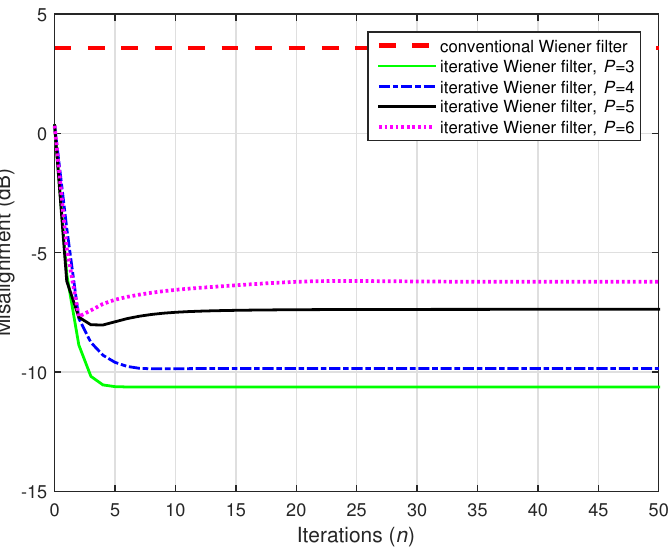
Figure 13. Performances of the conventional and iterative Wiener filters, using N = 2500. The input signals were independent AR(1) processes, M = 4, L = 500, and SNR = 10 dB.